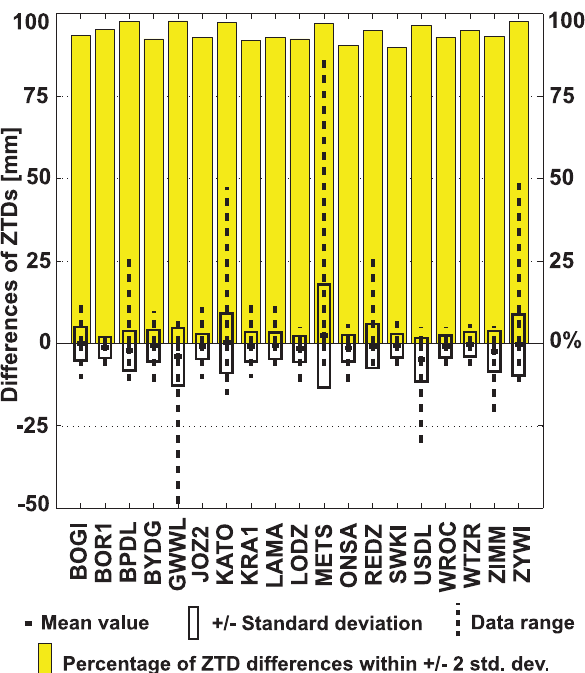
Fig. 7. Baseline skeleton (21 stations) for ASG-EUPOS network